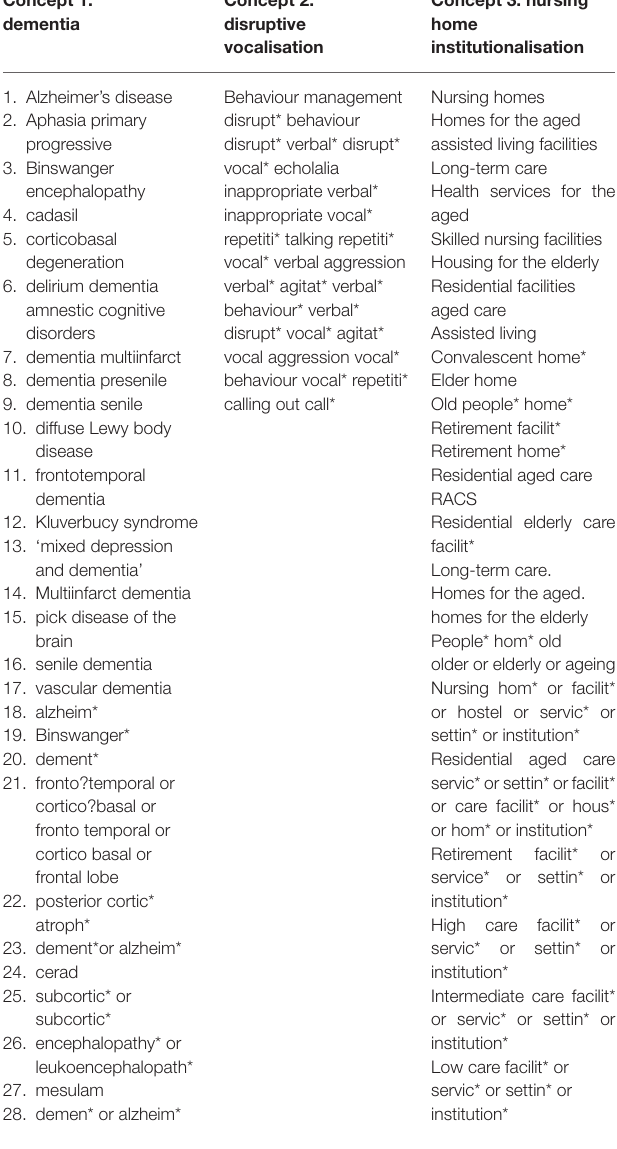
TABLE 1 | Search strategy